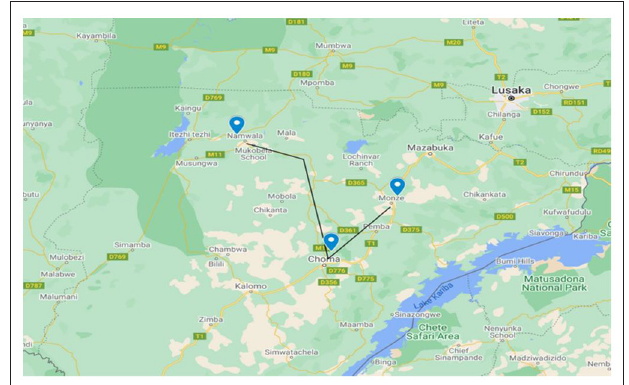
FIGURE 1 | Map of the study areas (Choma, Monze and Namwala). Source: Zambia maps.